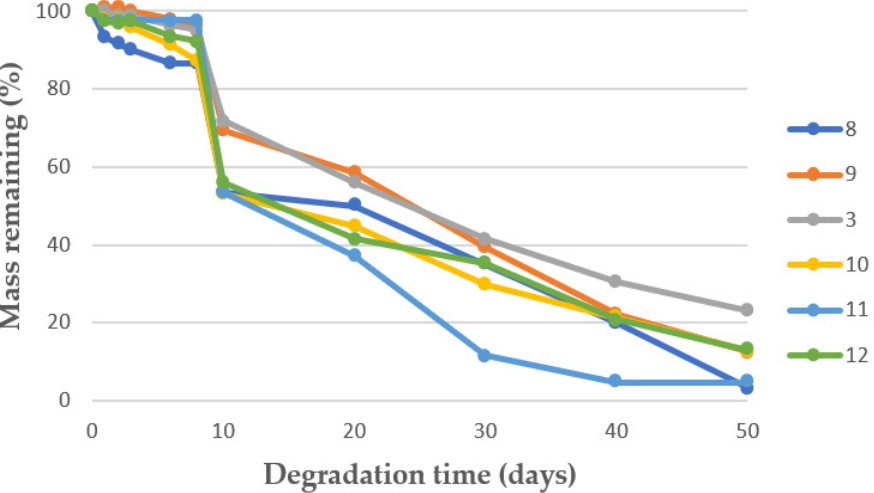
Figure 9. Mass remaining vs. degradation time in PBS solution of the scaffolds produced under different pressure levels.